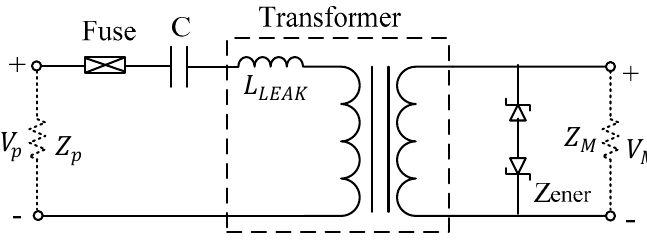
Figure 8. Coupling transformer [81].